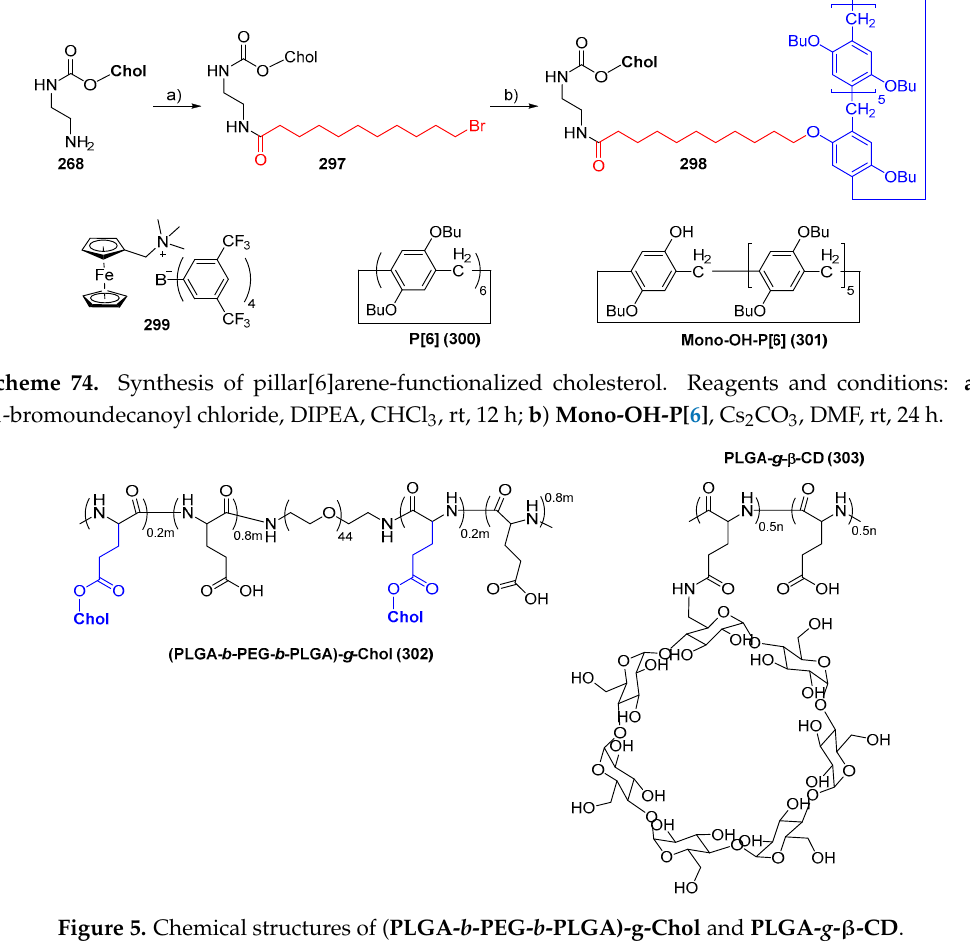
Figure 5. Chemical structures of ( PLGA- b -PEG- b -PLGA)-g-Chol and PLGA- g - β -CD .